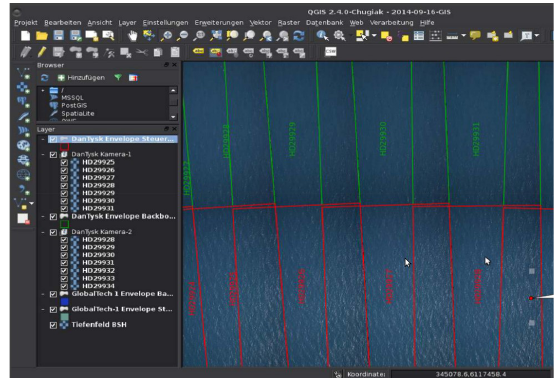
Figure 1. Example of a series of georeferenced, overlapping aerial images shown in QGIS